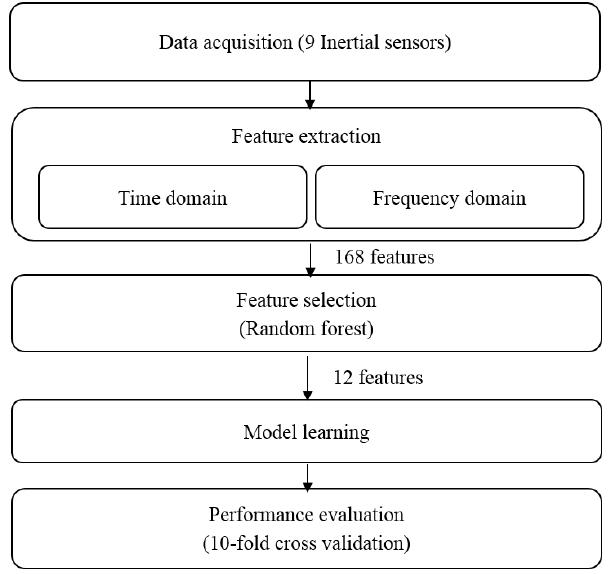
Figure 6. Steps of the activity recognition process using features’ extraction and selection.